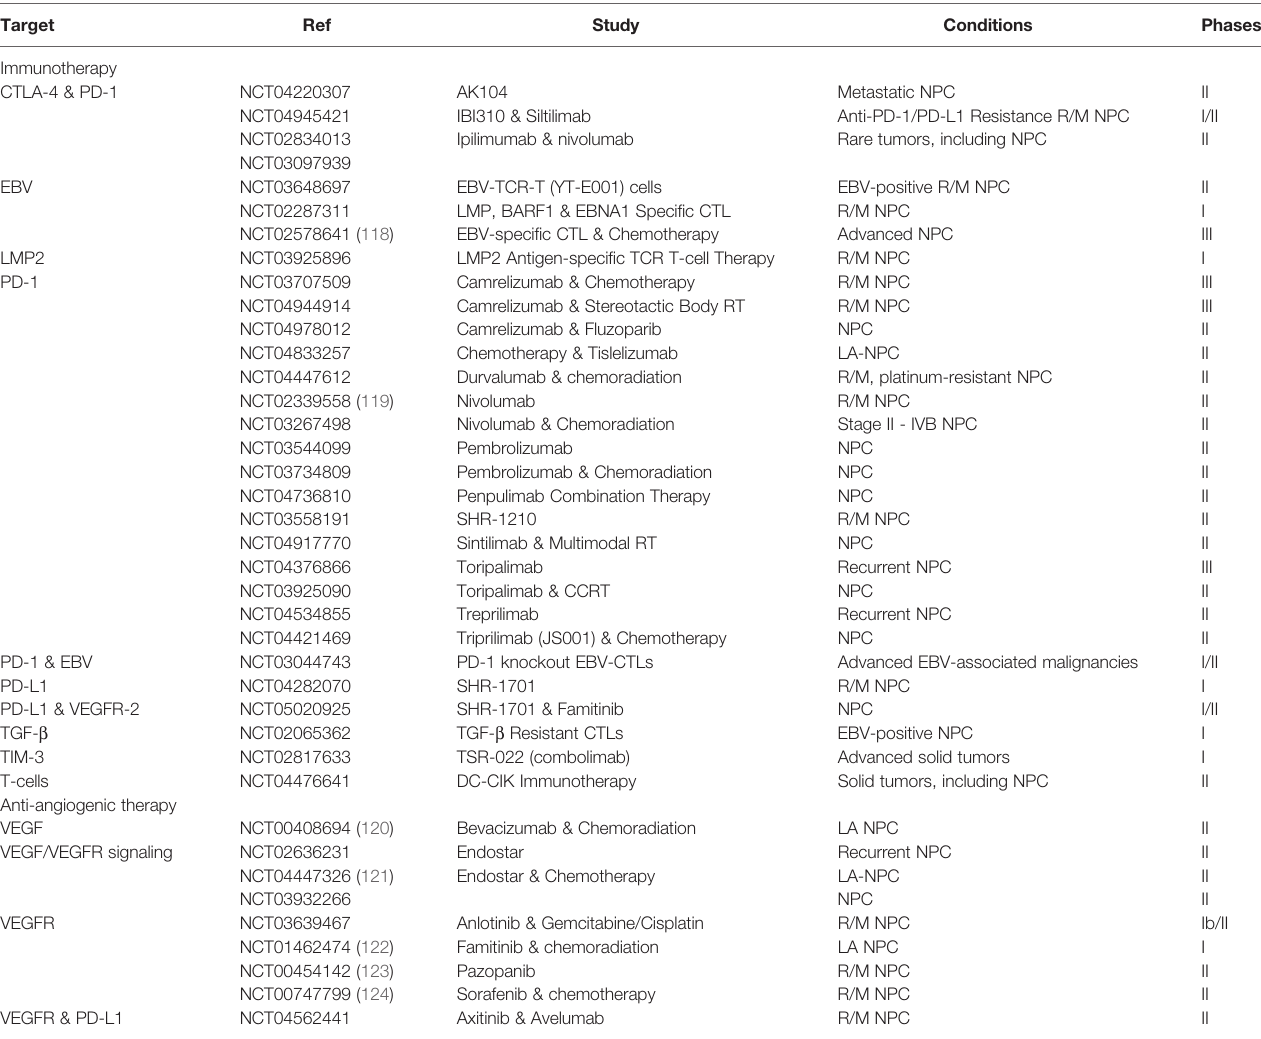
TABLE 2 | Clinical studies targeting NPC microenvironment.